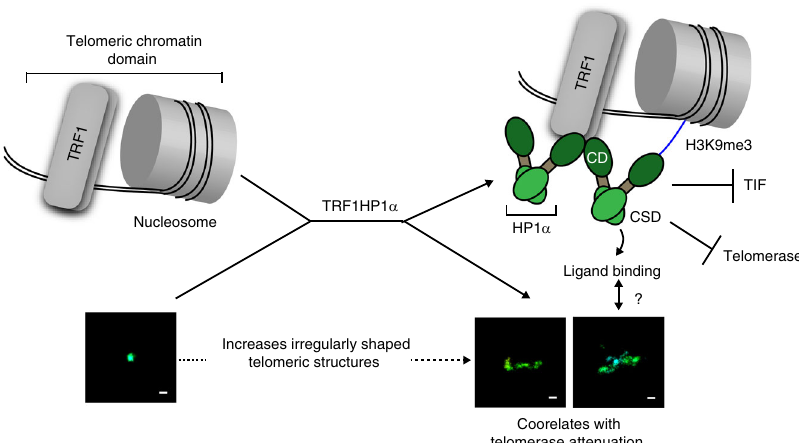
Fig. 7 Model for how enhanced heterochromatin by telomere-tethered HP1 α impacts telomere maintenance. Diagram of working model. Bar: 100 nm. Below the drawings: Representative reconstructed single telomere STORM images. See text